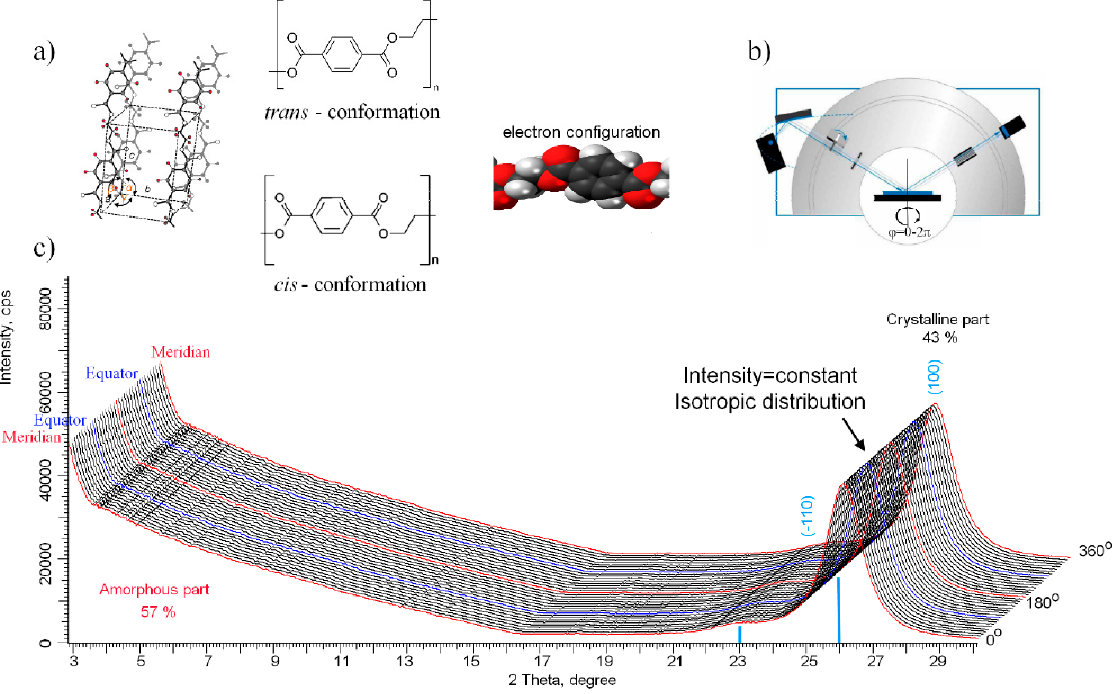
Figure 1. ( a ) Schematic representation of the PET crystalline lattice, its conformations and electron configuration; ( b ) Diagram of the X-ray diffractogram survey geometry; ( c ) X-ray diffractogram of the pristine PET sample in the φ = 0–2 π geometry (blue lines show equator, red lines the meridian).